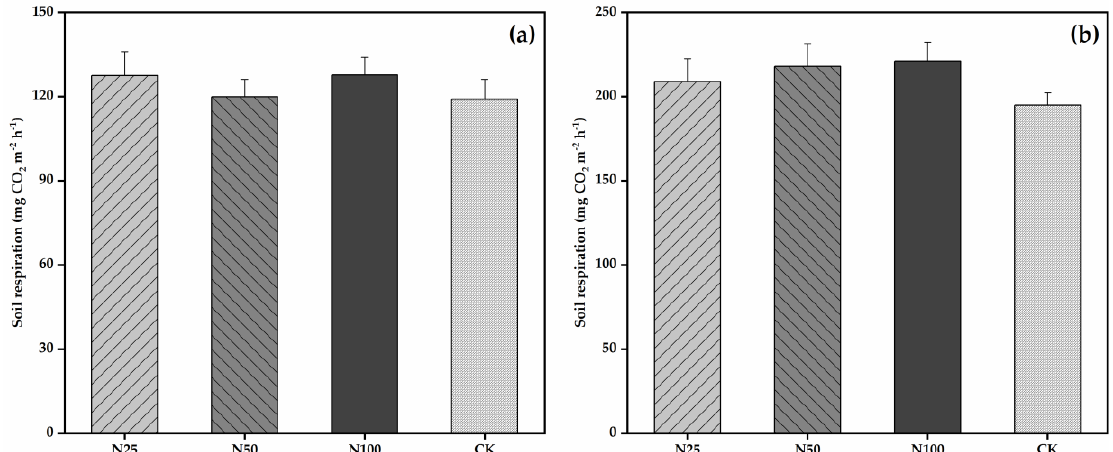
Figure 3. Mean R S under different N treatments in the dry season ( a ) and wet season ( b ). N25, N50, N100, and CK represent 25, 50, 100, and 0 kg N ha −1 a −1 N addition treatments, respectively. Error bars denote the standard errors of the means. No significant variations were found among the four N treatments by one-way ANOVA regardless of season. Table 3. Parameters of different regression models between R S , soil temperature (T), and soil moisture (W).